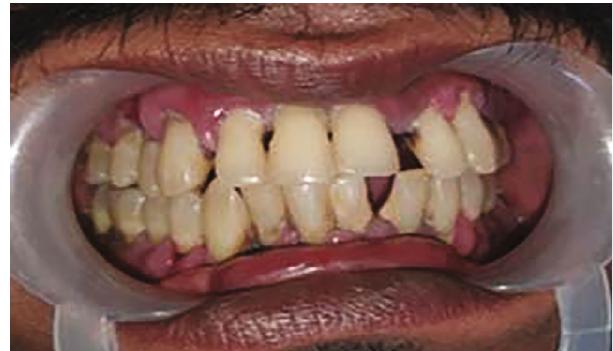
Figure 1: Clinical oral examination.